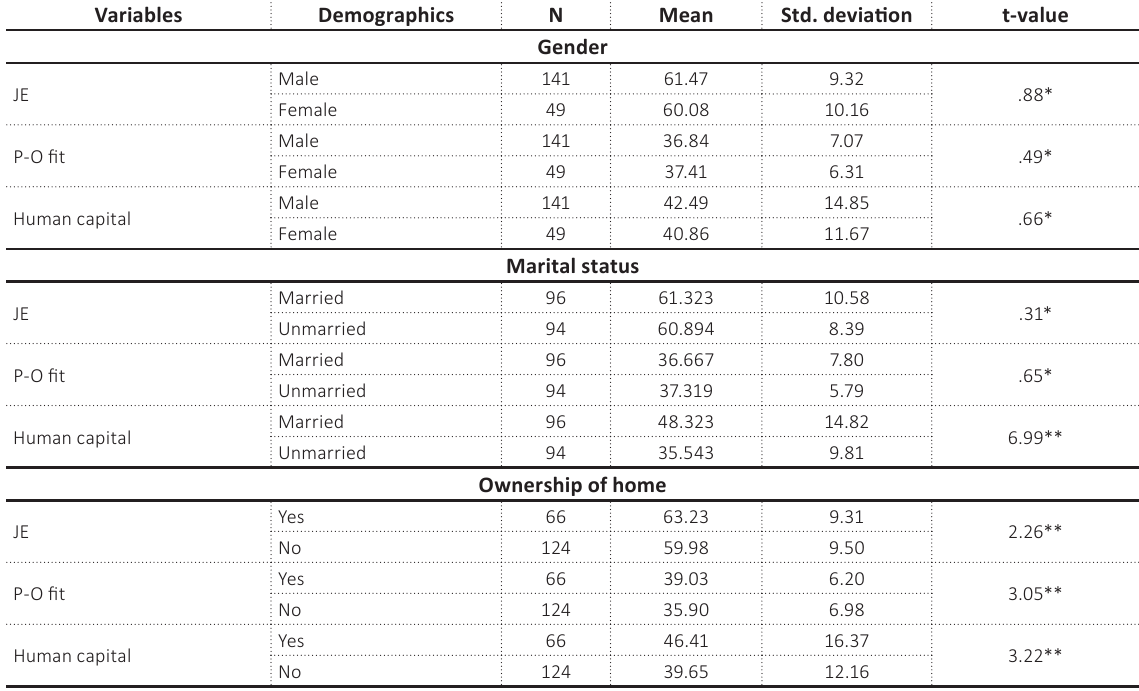
Table 9. Data and t-value based on demographics Variables